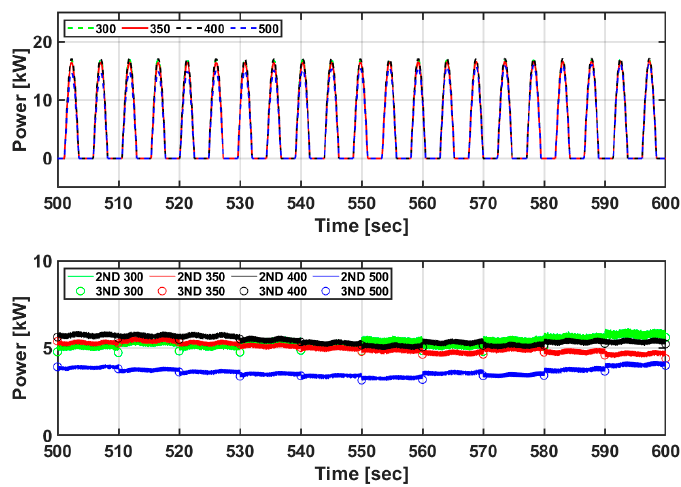
Figure 12. Comparison of power generation results according to the initial reference rpm of the speed control algorithm under regular wave conditions (legend indicates initial rpm).